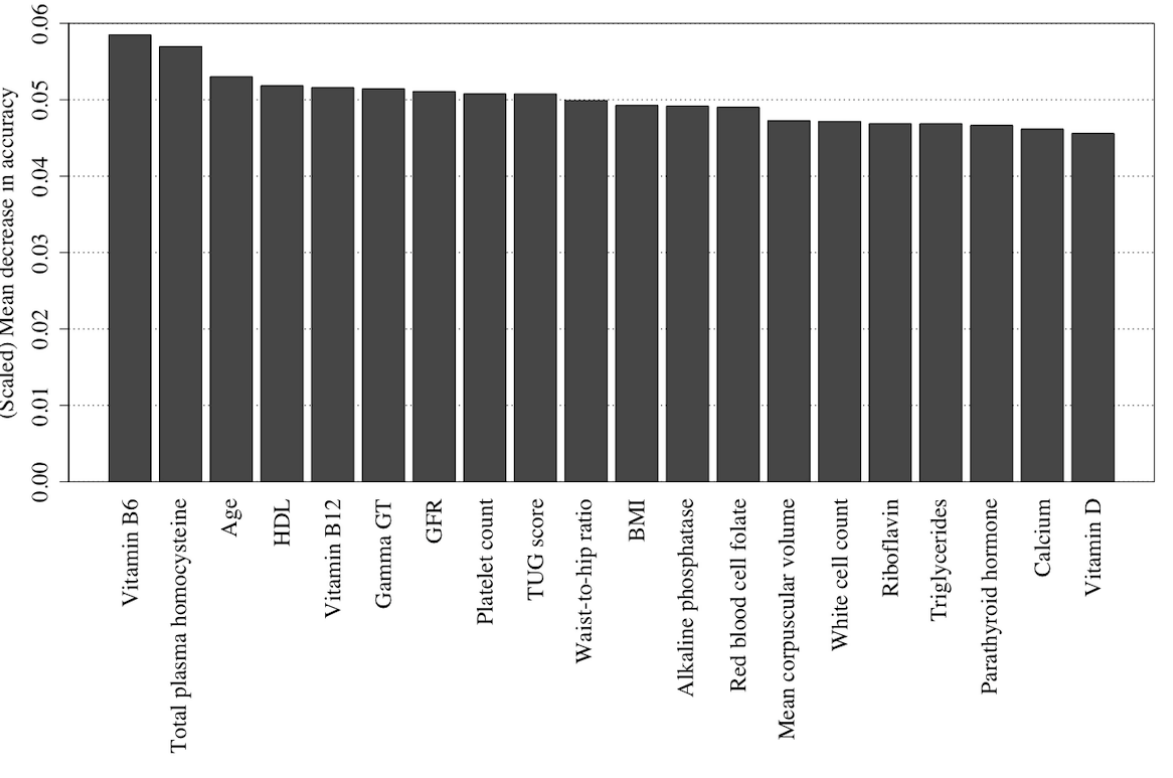
Figure 14. The 20 most important features for predicting rate of the Repeatable Battery for the Assessment of Neuropsychological Status change as detected using feature permutation using a random forest classifier. Gamma GT: Gamma-glutamyl transferase; GFR: glomerular filtration rate; HDL: high-density lipoprotein; TUG: Timed Up and